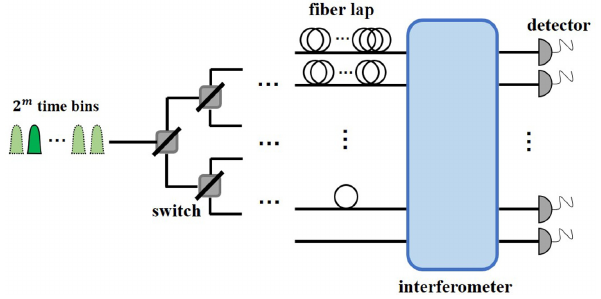
FIG. 7. The scheme of the X-basis measurement on the time- bin photonic